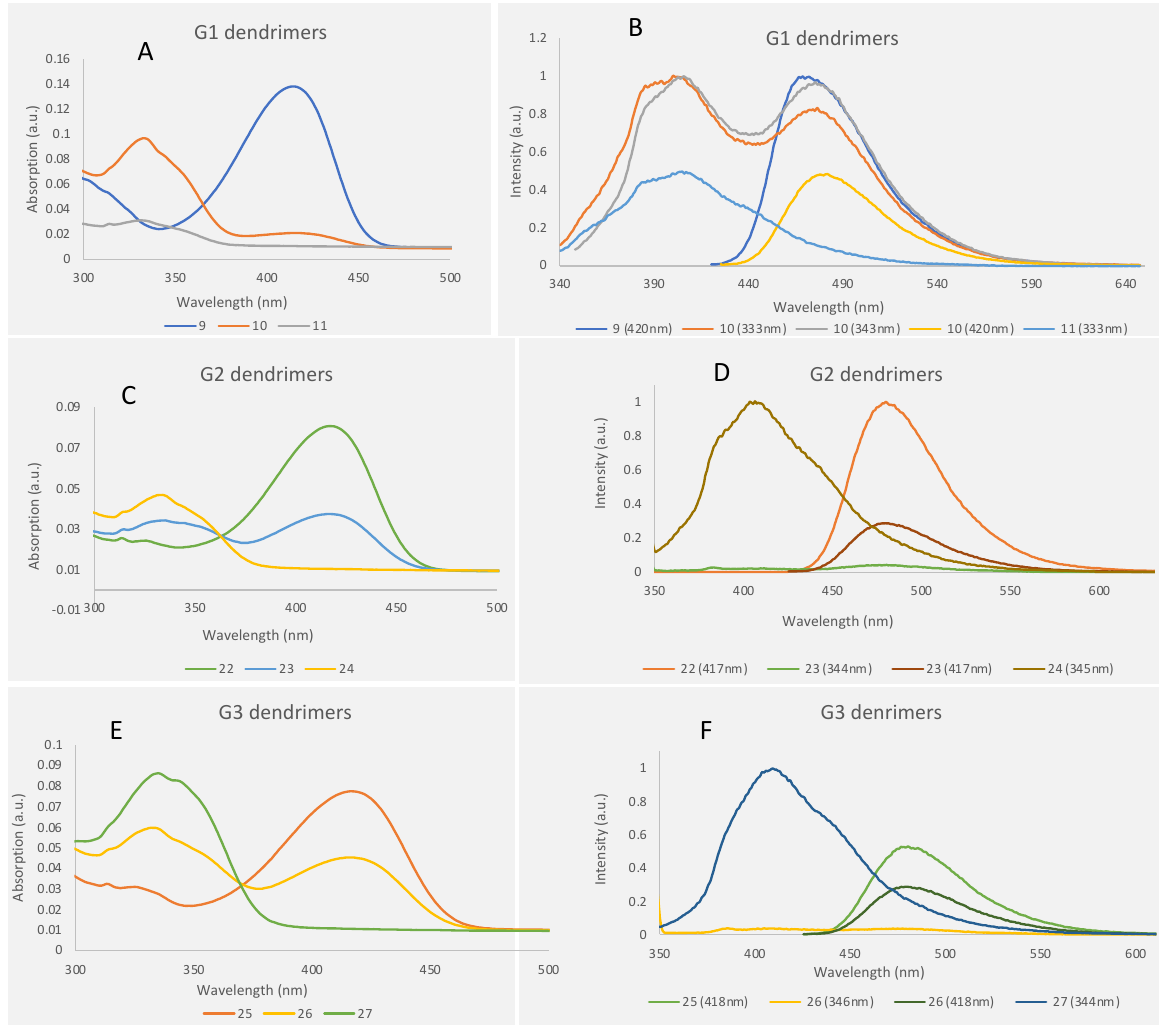
Figure 2. UV–vis spectra of G1–G3 dendrimers ( A , C , E ) and fluorescence spectra of homo − and Janus dendrimers ( B , D , F ). The UV–vis spectra were recorded 50 mM concentration using 1:1 mixture of DCM and methanol, whereas the emission spectra were recorded at 50 μ m concentration for blue– fluorescent dendrimers but 1 mM for naphthalimide-containing dendrimers. The Janus dendrimers were shown to cause fluorescence resonance energy transfer (FRET) as demonstrated by longer emission wavelengths for those dendrimers.